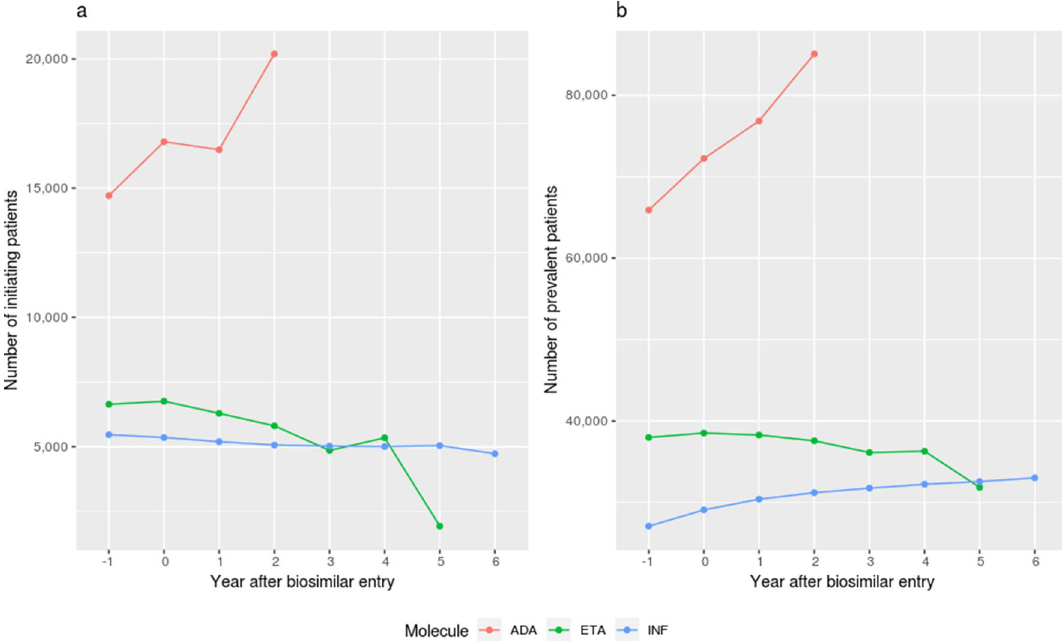
Figure 1. Number of patients initiating TNF-alpha inhibitor ( a ) and prevalent users of TNF-alpha inhibitor ( b ) between year − 1 and 6 (if applicable) after first biosimilar entry for each molecule. ADA, ETA and INF refer to adalimumab, etanercept and infliximab respectively. Adalimumab year 2 was 98% complete, infliximab year 6 67% and etanercept year 5 39%, from market entry date anniversary to study end